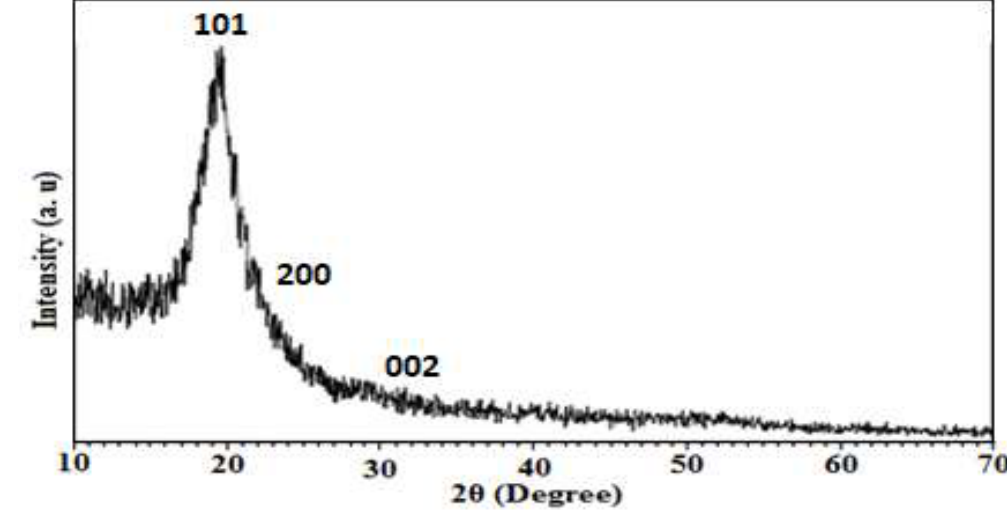
Figure 8: XRD pattern of PVA at concentration of 12 wt.%